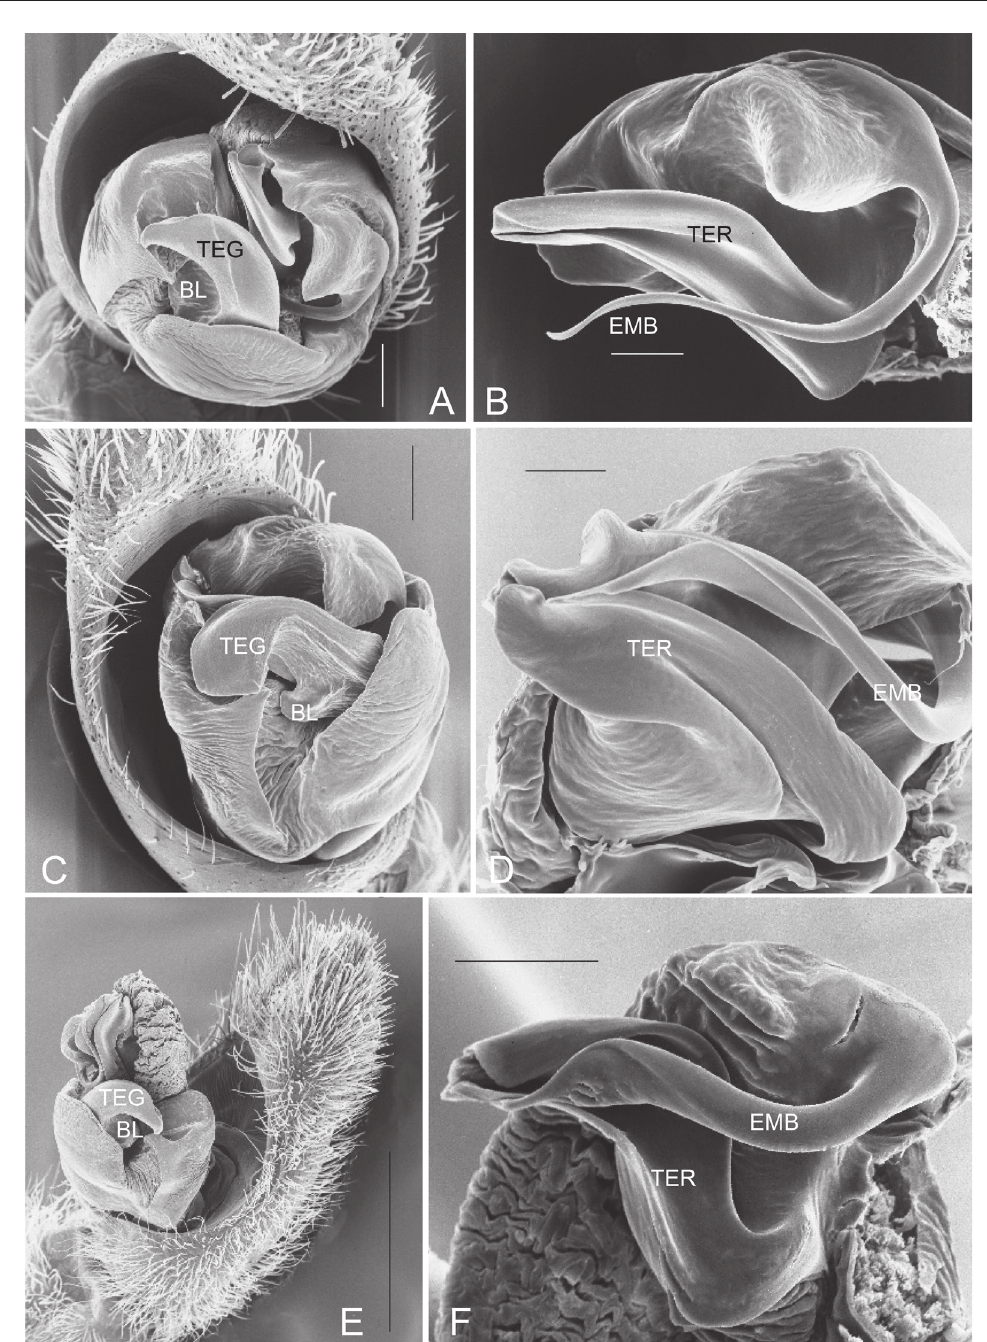
Fig. 2. Scanning electron micrographs (SEM) of Tetralycosa Roewer, 1960, male pedipalps. A . T. alteripa (McKay, 1976), right pedipalp, apico-ventral view (SAM NN21799). B . T. alteripa (McKay, 1976), palea region of right pedipalp, baso-ventral view (SAM NN21794). C . T. eyrei (Hickman, 1944), right pedipalp, retrolatero-ventral view (SAM NN21741). D . T. eyrei (Hickman, 1944), palea region of right pedipalp, ventral view (SAM NN21737). E . T. alteripa (McKay, 1976), left pedipalp, retrolatero-ventral view (Sinclair Gap Lake, South Australia; PH, pers. collection). F . T. wundurra (McKay, 1979), palea region of right pedipalp, ventral view (Lake Daringdella, Western Australia; P.H., pers. collection). Abbreviations: BL = basal lobe of tegular apophysis; EMB = embolus; TEG = main branch of tegular apophysis; TER = terminal apophysis. Scale bars: A = 0.5 mm; B–C, F = 0.2 mm; D = 0.1 mm; E = 1.00